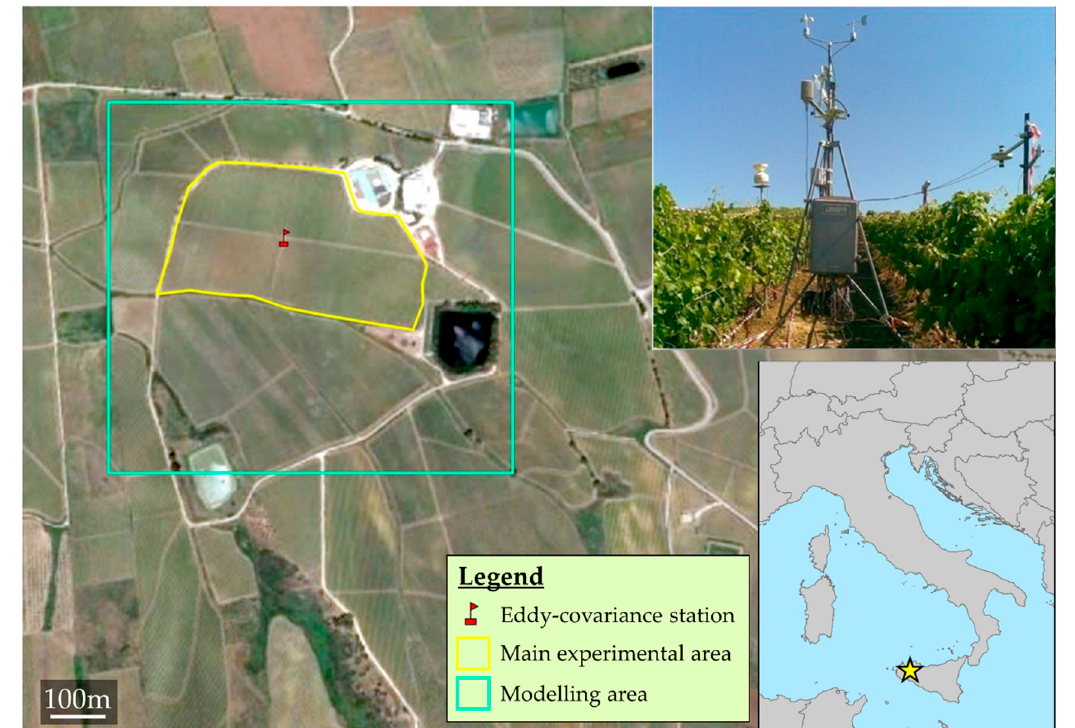
Figure 2. Location of the target area in Sicily. In the upper-right corner, a photograph of the eddy covariance station, from [39].